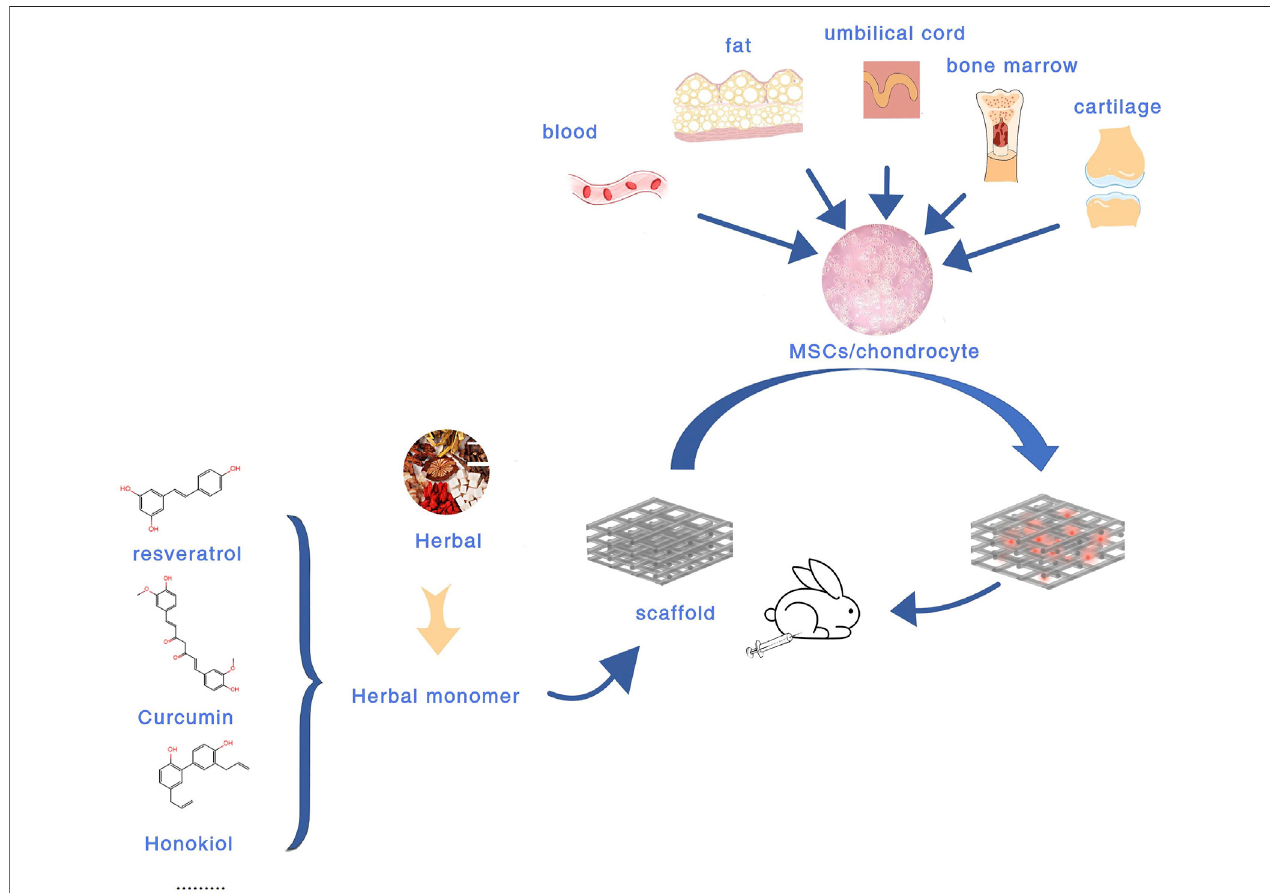
FIGURE 1 | Experimental fl ow chart of IA injection of BDEs-loaded biomaterial